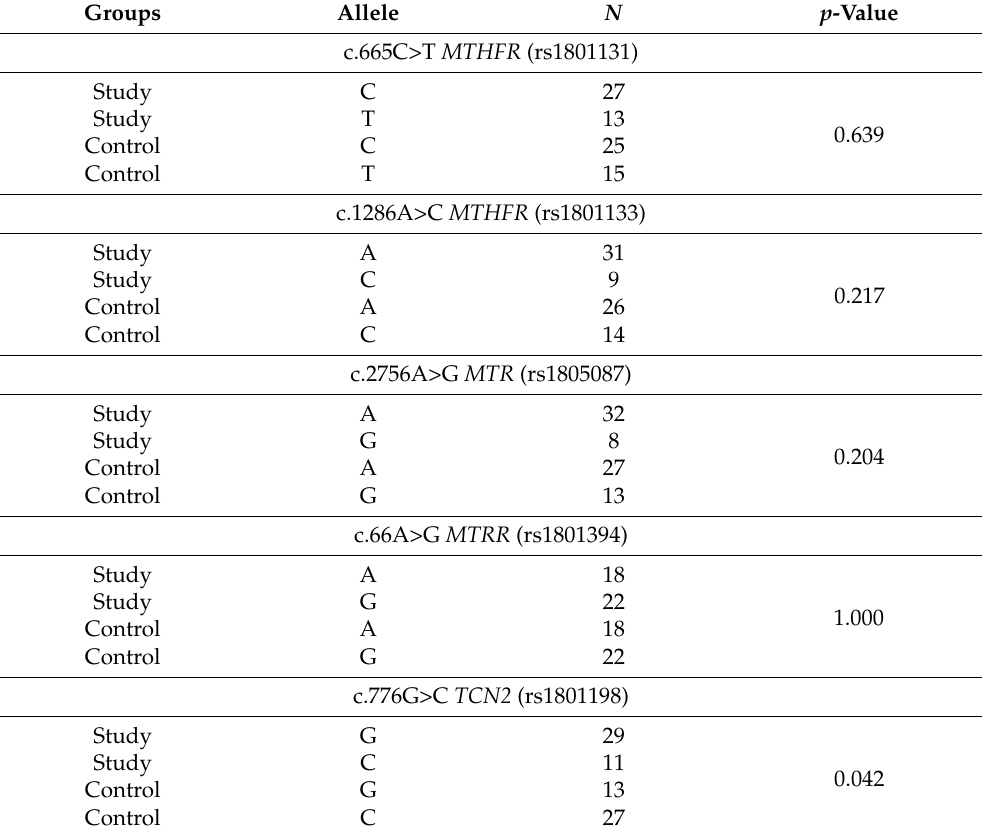
Table 1. Distribution of reference and alternative alleles in the control and study groups.